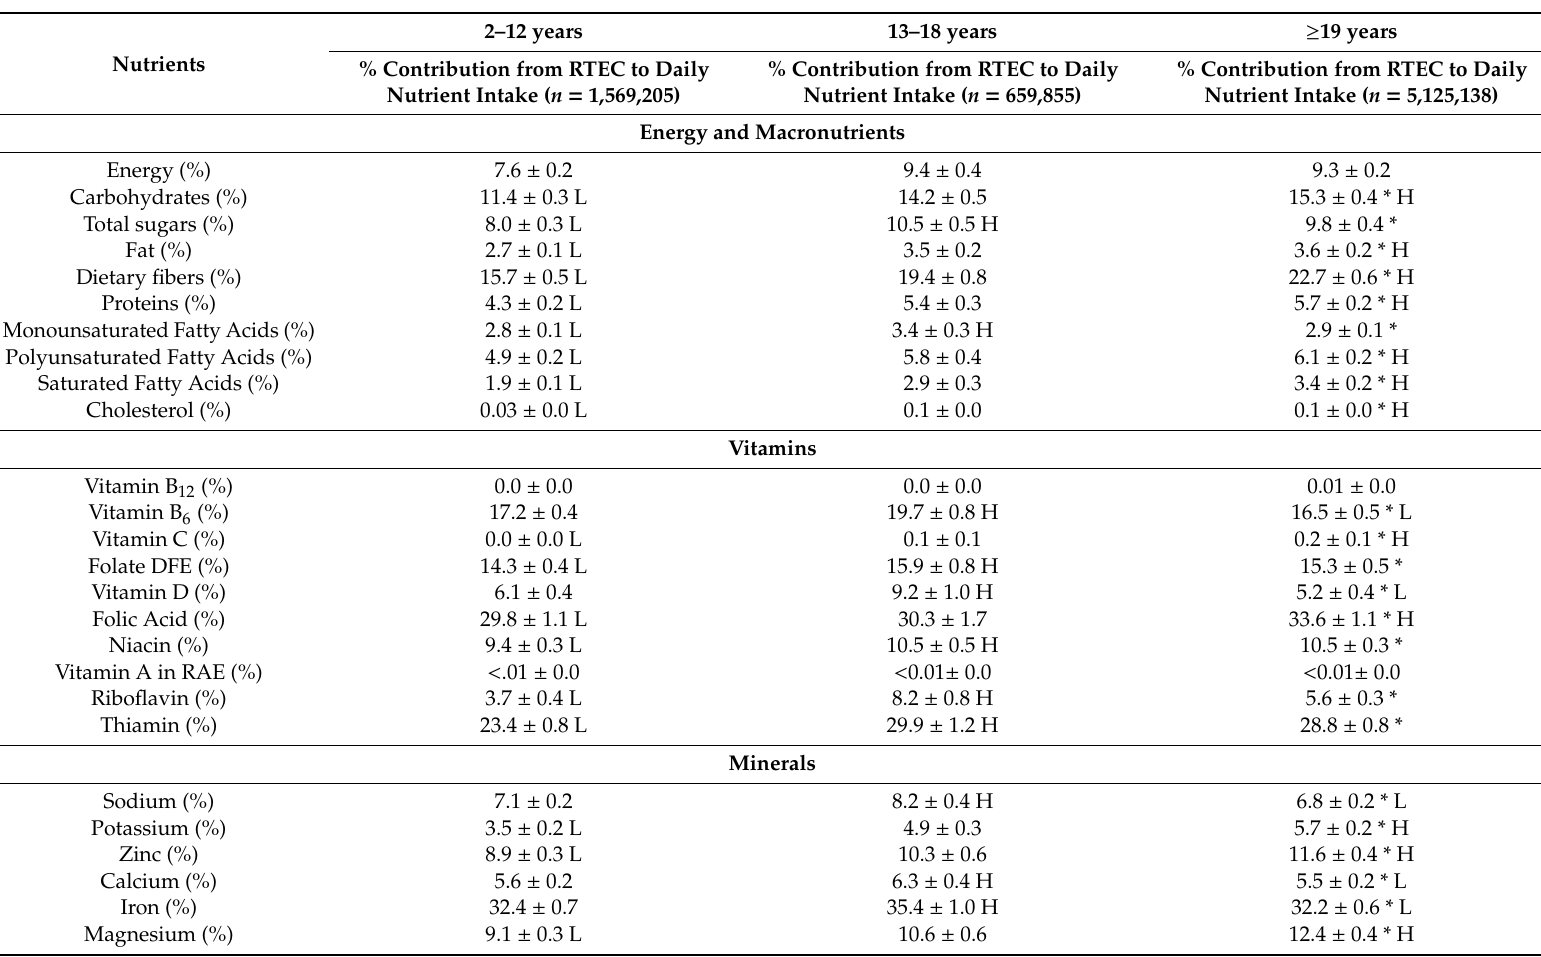
Table 4. Represents % contribution of nutrients from ready-to-eat cereal to mean intake for daily nutrients for three age groups among RTEC consumers only 1 .